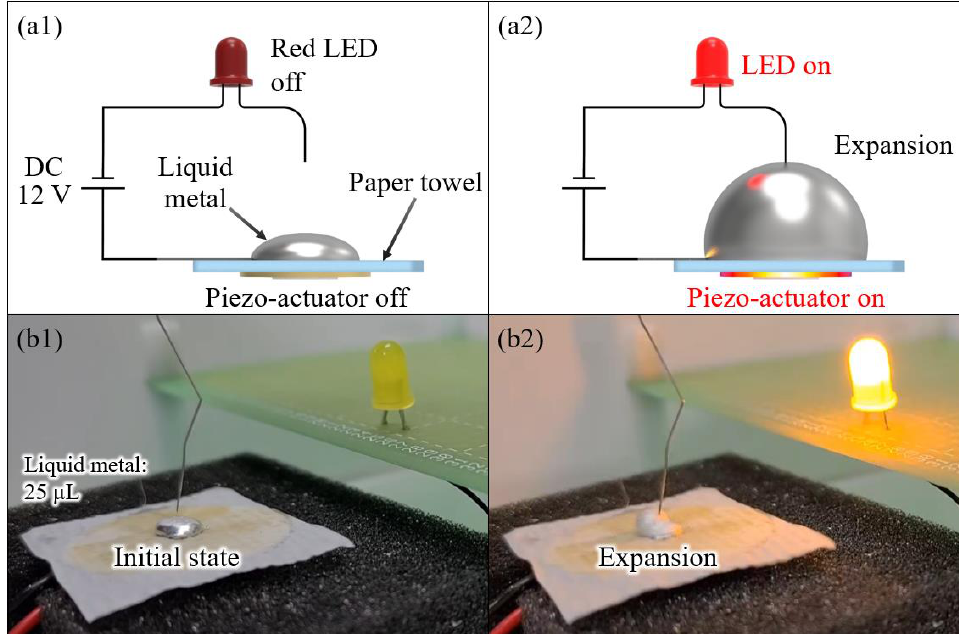
Figure 8. ( a ) A conceptual schematic of the circuit using liquid metal droplet expansion for an electrical switching application; and ( b ) the time-lapse images of the maintenance of electric conductivity on the expansion of a liquid metal droplet.